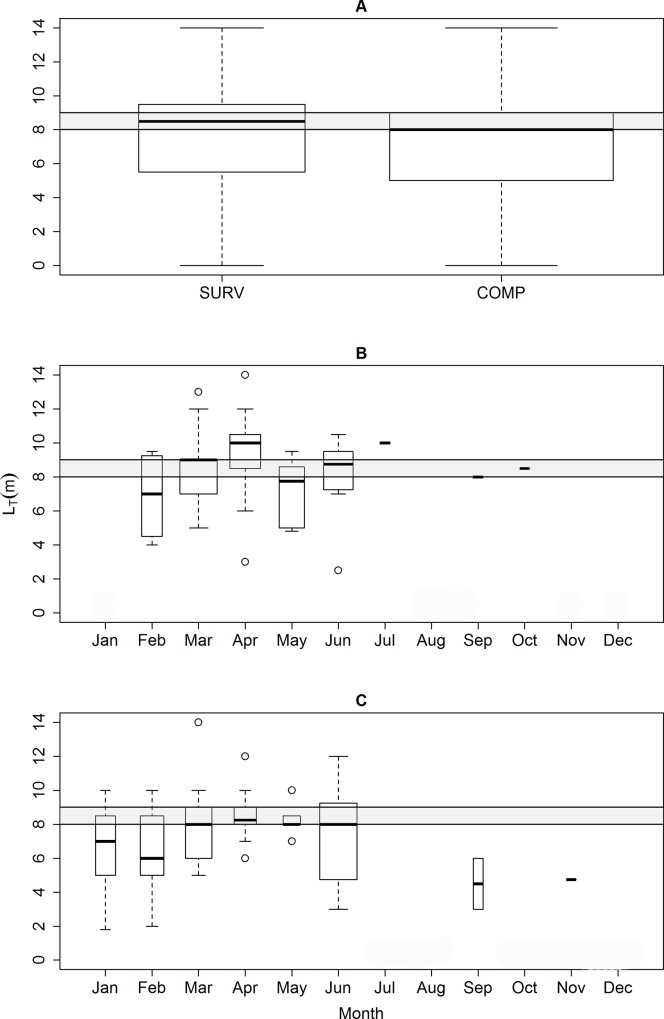
Distribution of whale shark lengths.(A) Comparison of R. typus sizes between SURV and COMP; and (B,C) size distribution per month for (B) SURV (n = 43) and (C) COMP (n = 79) in the ASPSP. Immature (below) and mature (above) animals are separated by a shaded area indicating the transitional 8.0–9.0 m size class. The width of the boxes is proportional to the square-roots of the number of observations in the groups, the horizontal bar is the median and the open circles indicate outliers.